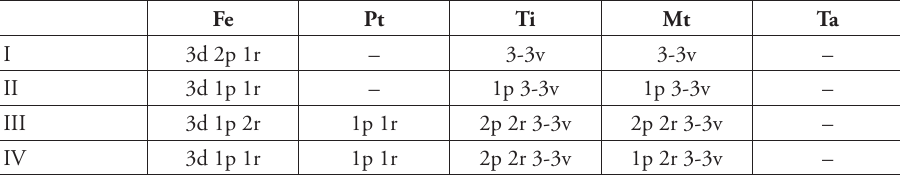
Epigyne as in Fig. 2A–B: epigynal teeth narrow and relatively short (shorter than width of atrium); septum short with weakly sclerotized tip, about 0.3 times as long as wide; atrium with well delimited posterior margin, about 1.3 times longer than wide, about 4 times longer than septum, subequal to width of septum; copula- tory opening hidden by anterior margin of atrium; receptacles long, about 2 times longer than wide, separated by 2.5 times their diameters; copulatory ducts with 3 parts, the basal part running from receptacle posteriorly ( Bd ), median part running anteriorly ( Md ), and terminal part ( Td ) running posteriorly and leading to copula- tory opening; median part as wide as terminal and 2 times longer than basal part; median part 1.5 times longer than receptacle; median parts touching each other; hoods